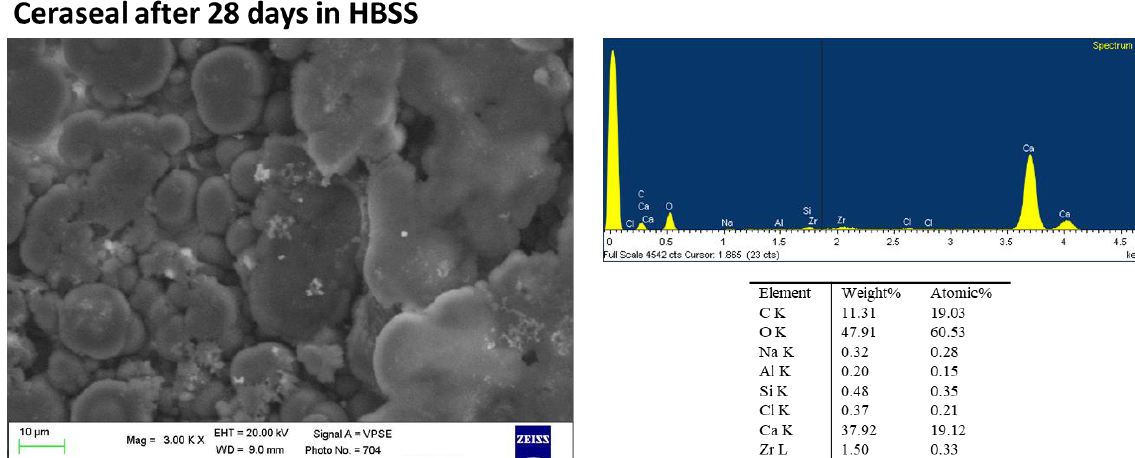
Figure 1. ESEM images at 3000× of Ceraseal before and after immersion in HBSS. Set Ceraseal sample was characterized by a regular surface with small granules widely spread. EDX revealed the constitutional elements of the materials, namely Zr, Ca, Si and Al. After 28 days immersion, an irregular surface was observed. Numerous globular structures covering the sealer surface were detected. EDX revealed an increase in Ca and a decrease in Zr and Si. No P was detected. Figures 2 and 3 show the average IR and micro-Raman spectra recorded on just extruded Ceraseal as well as on the surface of set disks before and after aging in HBSS for 28 days.